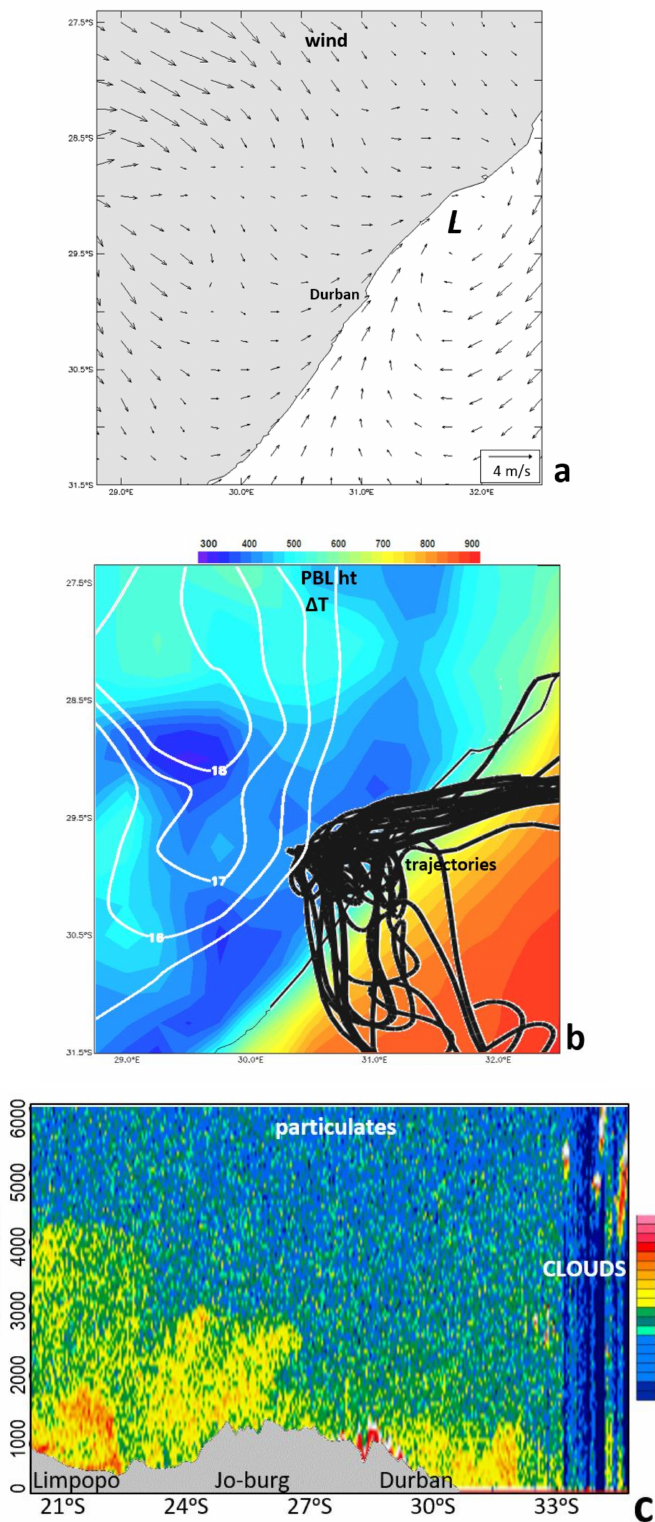
Figure 7. Mean July 2015: ( a ) ERA5 surface winds, ( b ) PBL height and twice-daily HYSPLIT-simulated emission trajectories from the Durban-area; white contours >15 ◦ C are winter mean in situ T max –T min values. ( c ) N–S vertical section on 30.5 ◦ E of particulate density on 12 July 2015 (ppb) from CALIPSO satellite lidar 0.532 µ m backscatter. Vectors in ( a ) are at 25 km